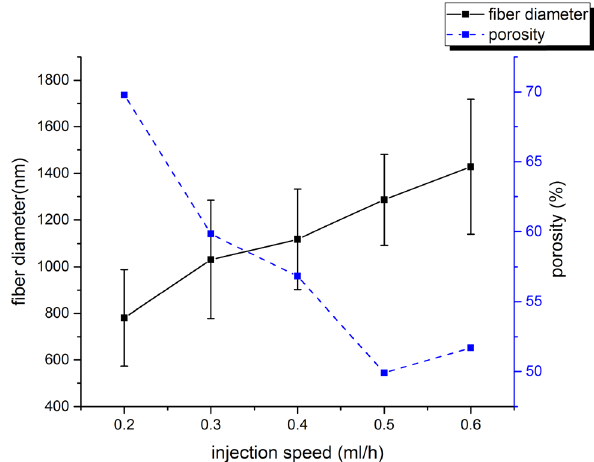
Figure 9: The relationships between CSBS fi ber diameter, nonwoven porosity, and injection